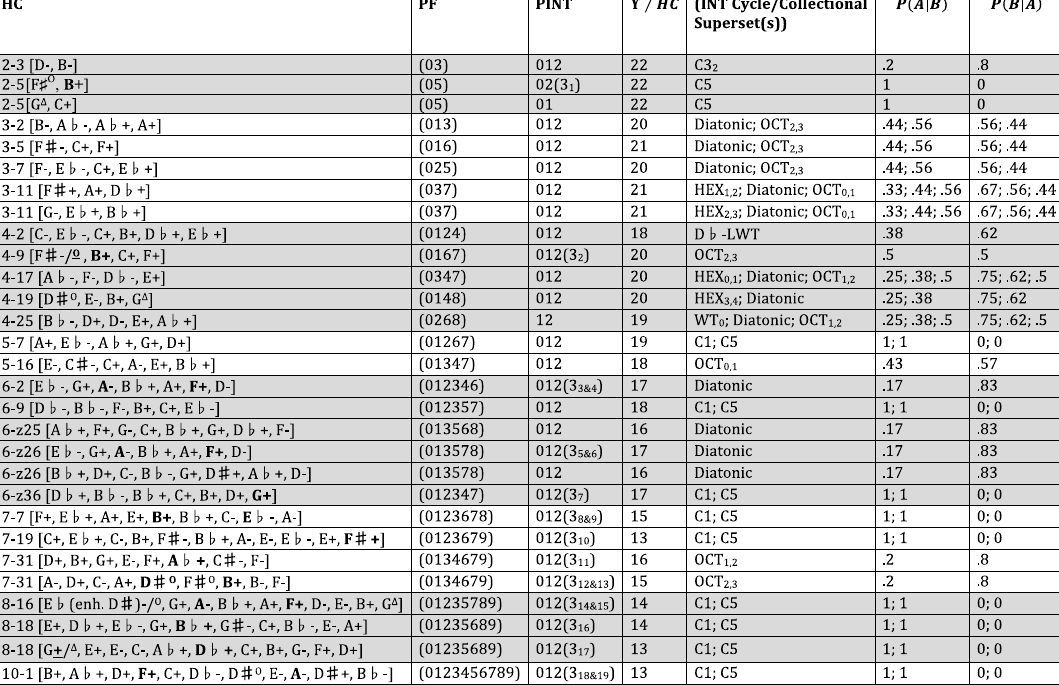
Figure A1. The Macklay Set Partitioned into Harmonic Classes